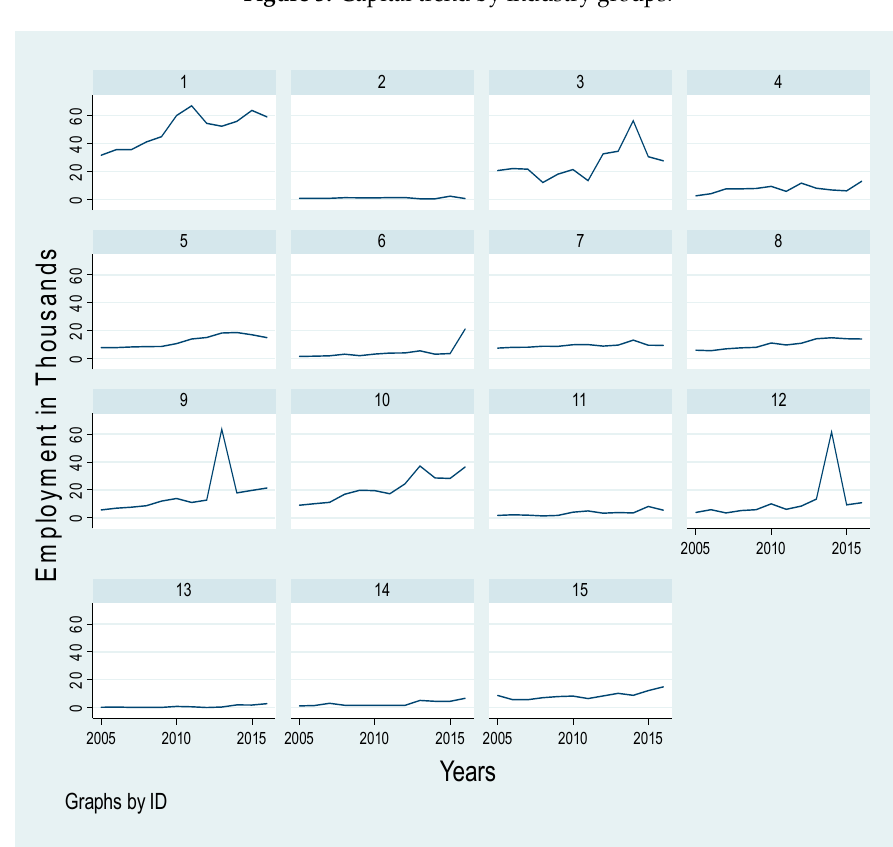
Figure 4. Employment trends by industry groups.